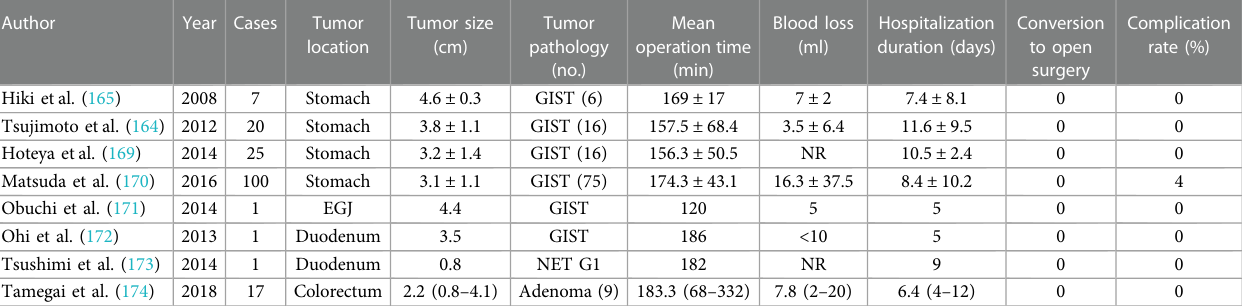
TABLE 11 Research studies of the classical LECS technique.